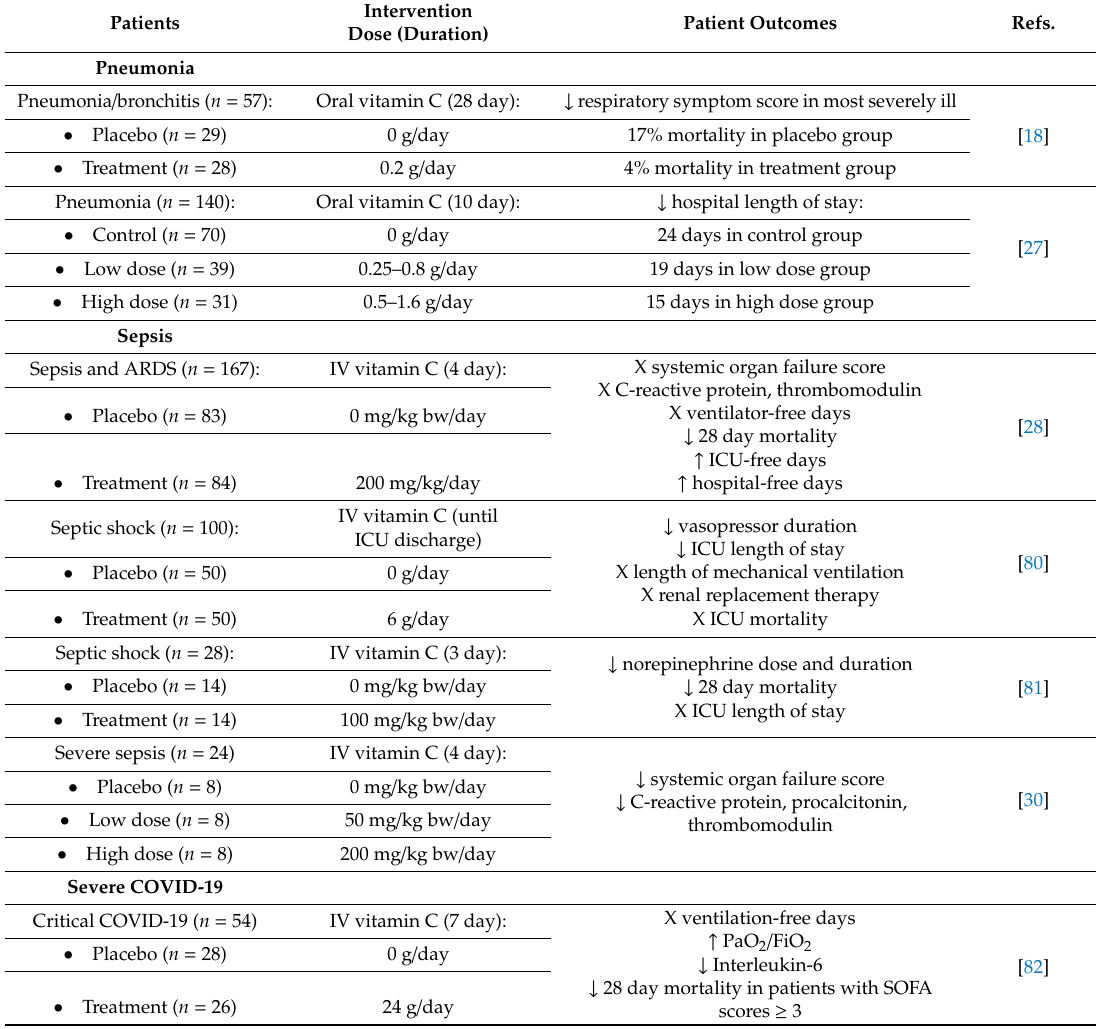
Table 2. Vitamin C trials in patients with pneumonia, sepsis and severe